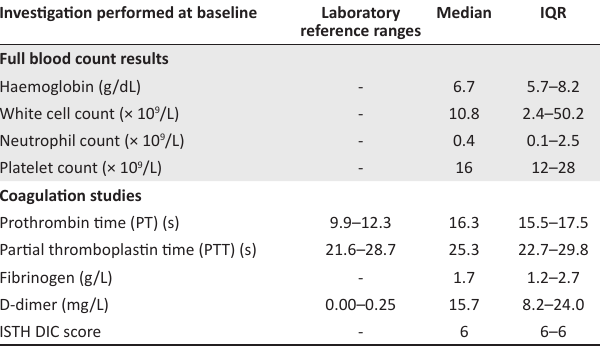
TABLE 2: Baseline full blood count results and coagulation studies of the cohort. Investigation performed at